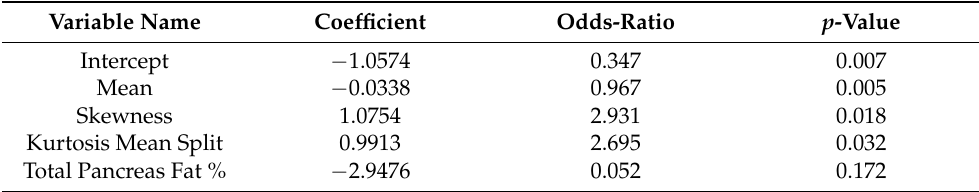
Table 1. Ordinary Least Squares (OLS) Logistic Regression